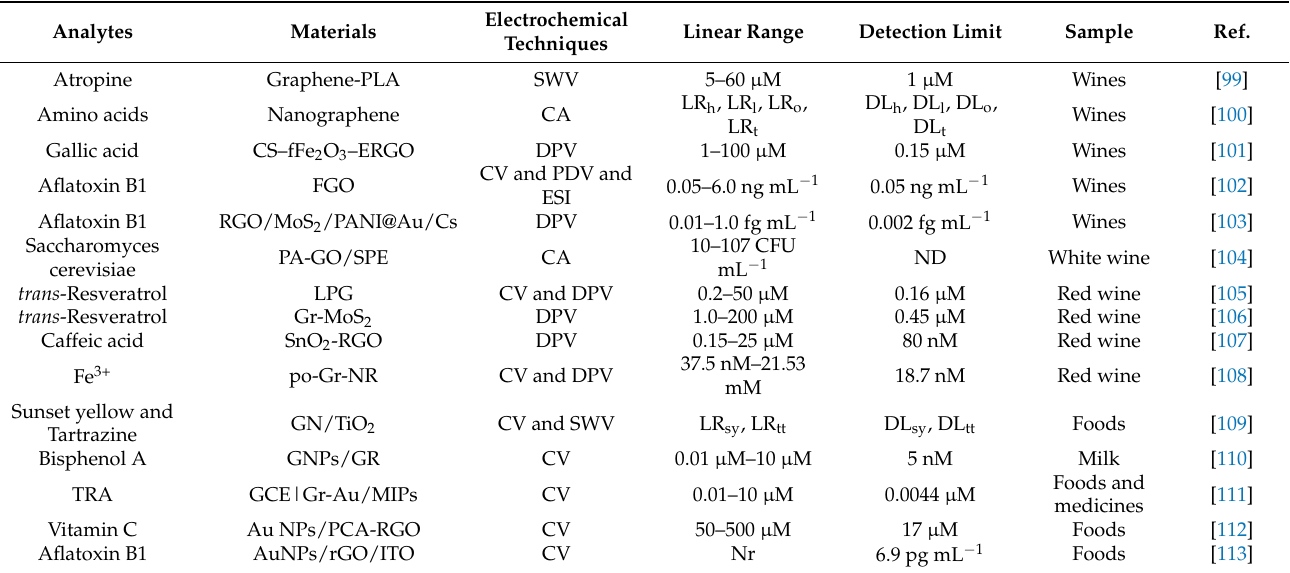
Table 3. Application of electrochemical sensors based on graphene-based materials associated with electrochemical techniques for the detection of different target analytes in foods and